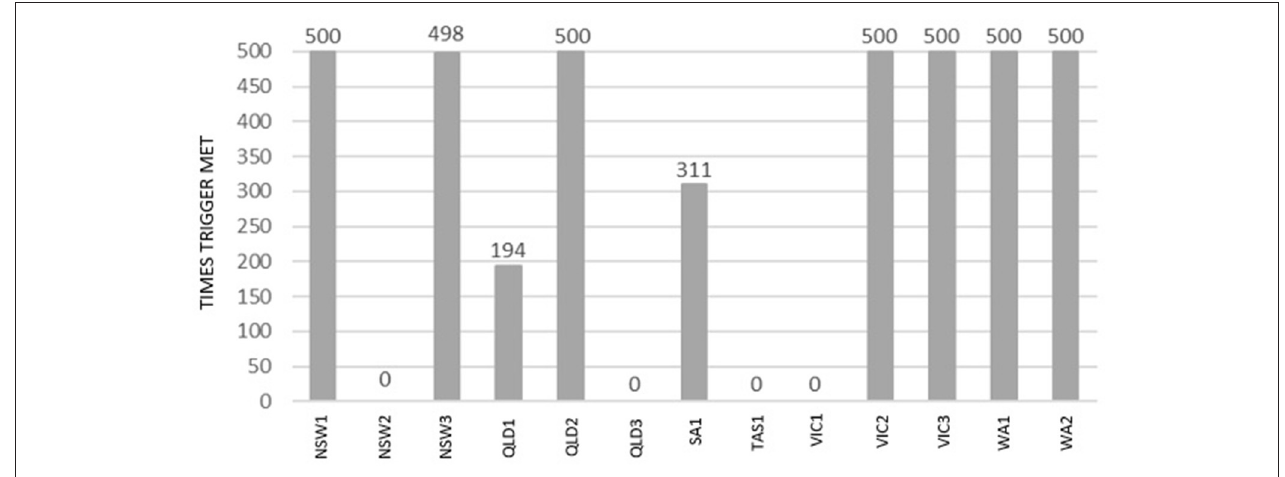
FIGURE 6 | Number of simulations the vaccination trigger was met during 500 simulations of Control Strategy 3 for each incursion scenario.